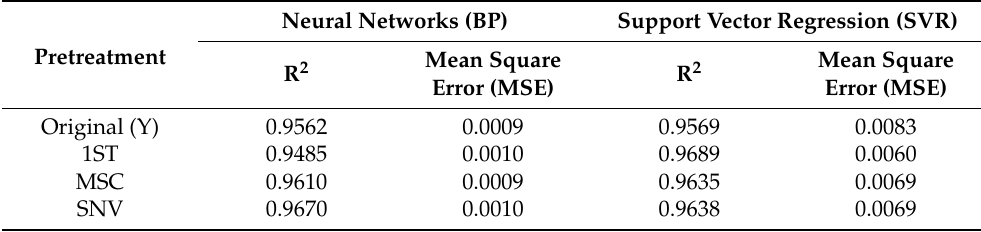
Table 2. Modeling results based on the full band.